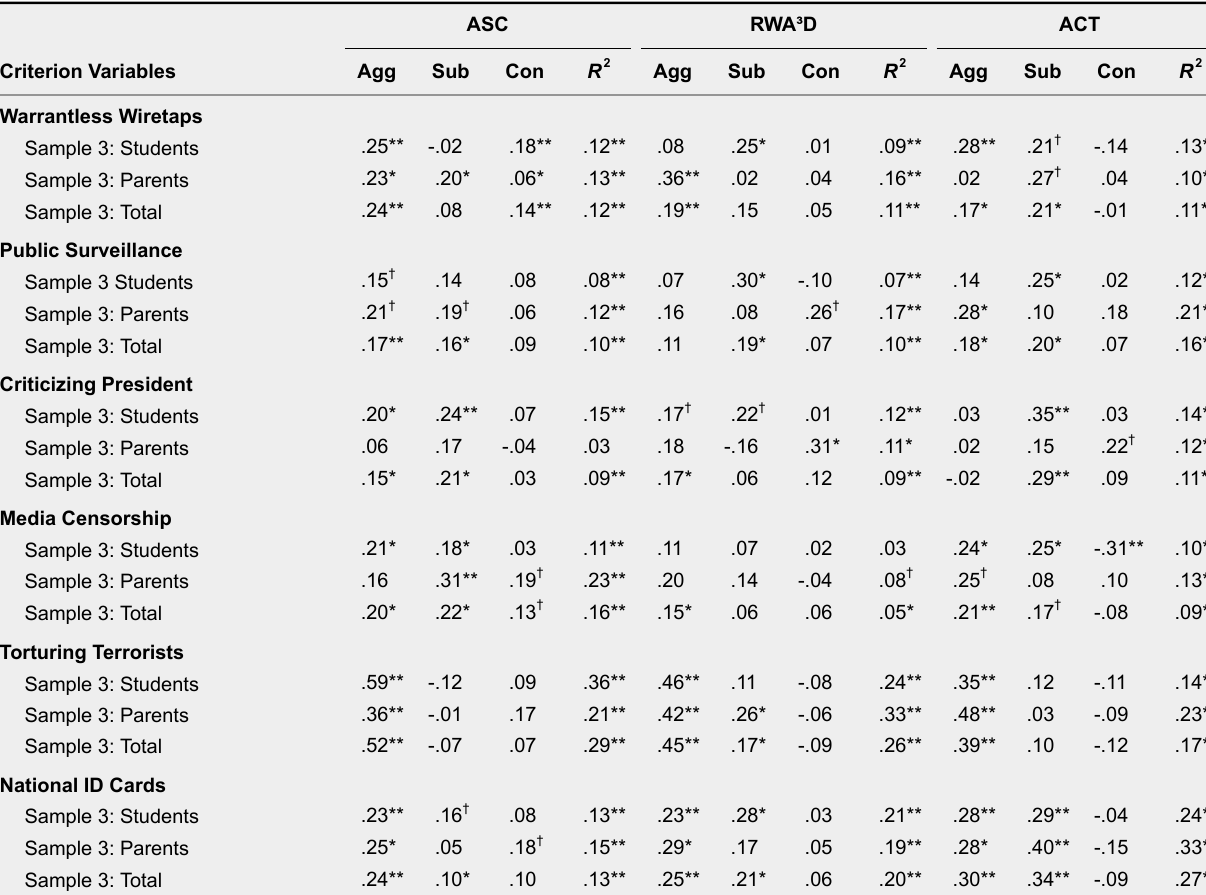
Beta Weights and R 2 in Predicting Support for Specific Anti-Democratic Policies